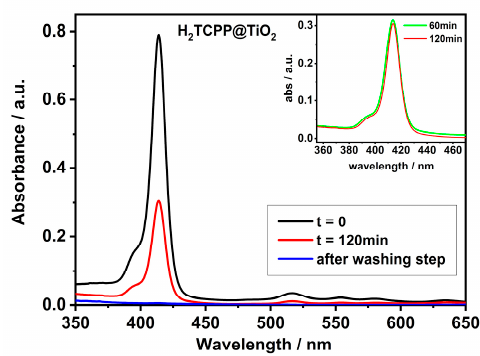
Figure 2. UV / Vis spectra (cuvette path length = 0.1 cm) of H 2 TCPP aqueous solution (20 µ M, pH = 5.8, black curve) and after 120 min. in the presence of 20 mg TiO 2 (red curve). The blue curve refers to the absorption of the supernatant solution after the H 2 TCPP@TiO 2 powder’s washing step. Inset: comparison between the absorbance of the same solution after 60 min. (green curve) and 120 min. (red curve) of functionalization.